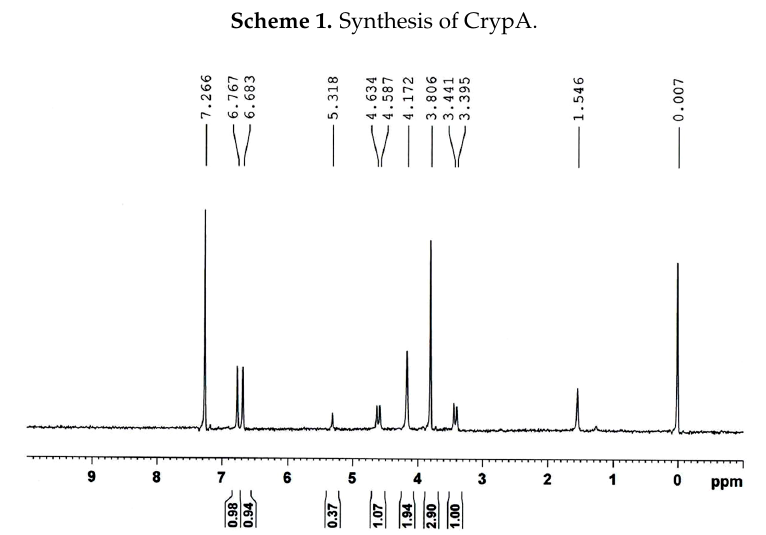
Figure 5. 1 H-NMR spectrum of the synthesized CrypA.